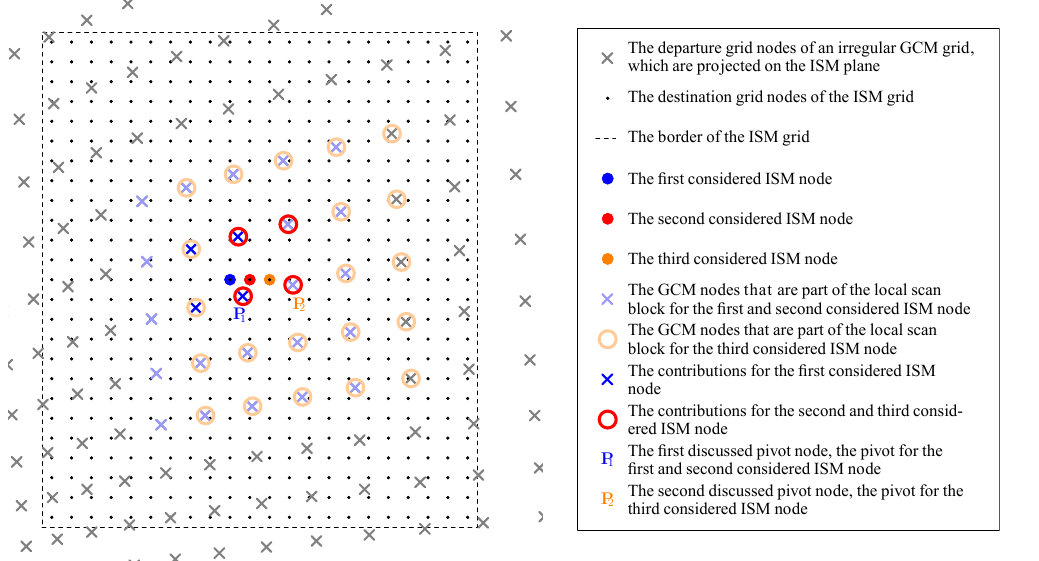
Figure 3. Situation sketch of the procedure to find a next scan block for a GCM to ISM mapping, in the case that the quadrant interpolation method is used. Consider the situation for which the four contributions ( ) are found for the first considered ISM node ( ). In order to find the contributions for the second considered ISM node ( ), a scan over a local block is conducted. This local block is constructed by taking the nearest contribution (the pivot) and extending the block in all directions by b . In this case is the pivot and the block is extended by two nodes in each direction. For the second considered ISM node, this results in a different set of contributions ( ). Because is the nearest contribution for the second considered ISM node as well, stays the pivot. Therefore the scan block remains unchanged in the next scan. Though for the third considered ISM node ( ) the contributions are the same as for the second considered ISM node, now becomes the pivot of the third considered ISM node. So the next scan is conducted over the marked GCM